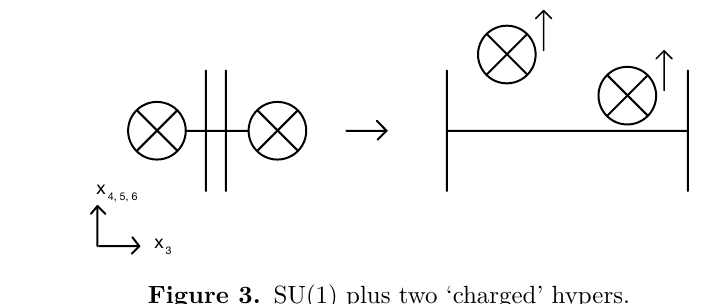
Figure 3. SU(1) plus two ‘charged’ hypers.